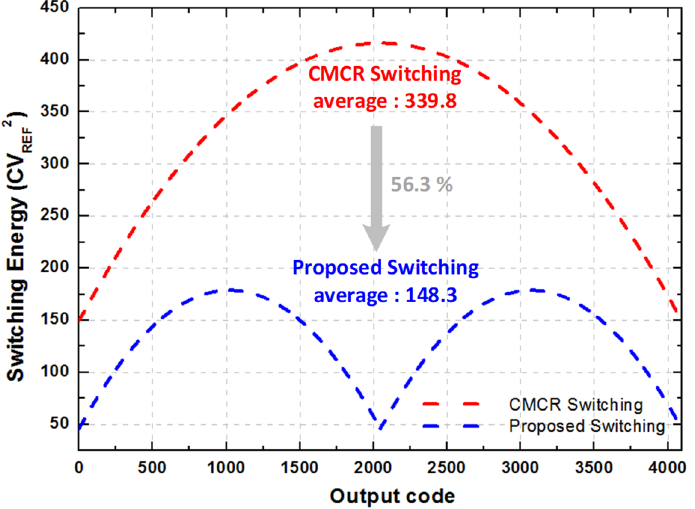
Figure 5. Comparison between switching energies of the proposed and conventional switching technique.